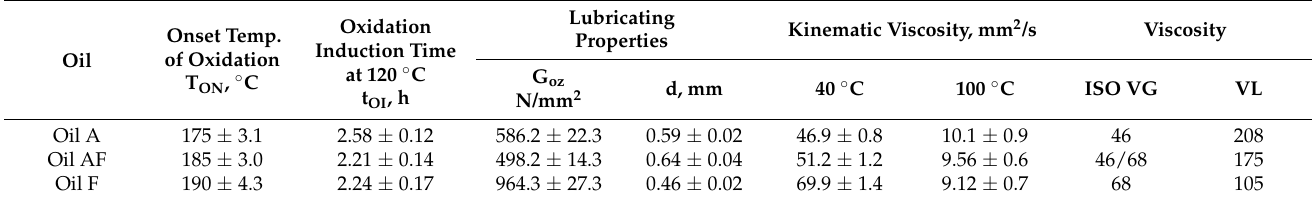
Table 4. The characteristics of base oils: vegetable A, vegetable–mineral AF, mineral F.